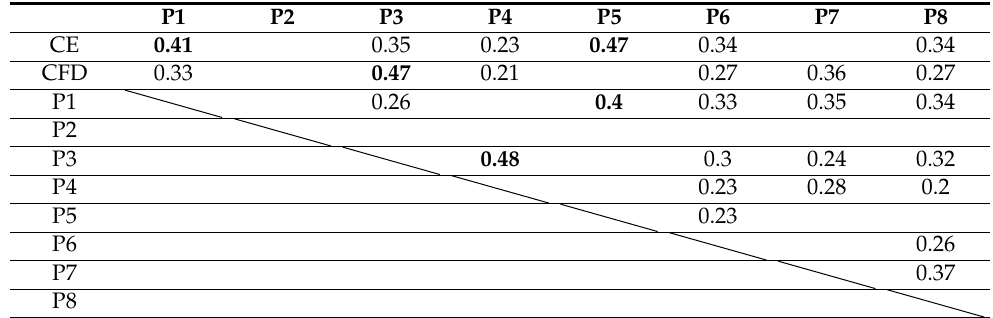
Table 3. CE, CFD levels versus Participants answers—correlation matrix for Nat images. Only significant Pearson correlation values are presented: r > 0.2 with α = 0.05. Highest values are highlighted in bold.